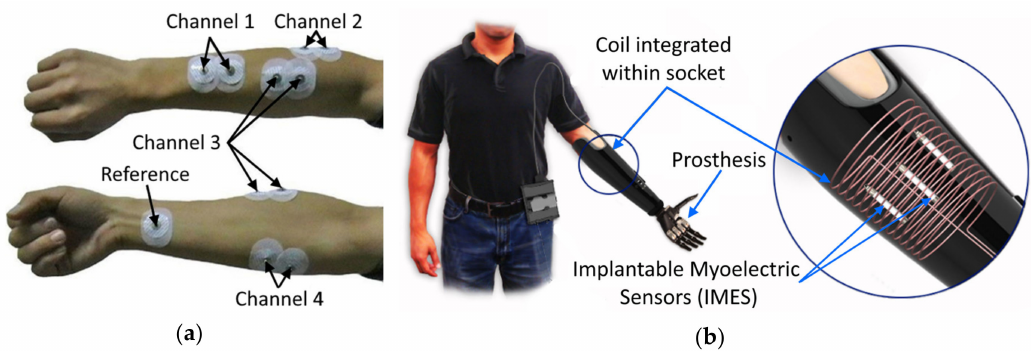
Figure 2. Electromyography: ( a ) illustration of typical mid-arm EMG measurement setup for four independent sEMG channels [46]. Adapted from [46], licensed under CC BY 4.0; ( b ) intramuscular electromyography with muscle-implanted wireless electrode modules (Implantable Myoelectric Sensors). This figure was adapted from [45] with permission from